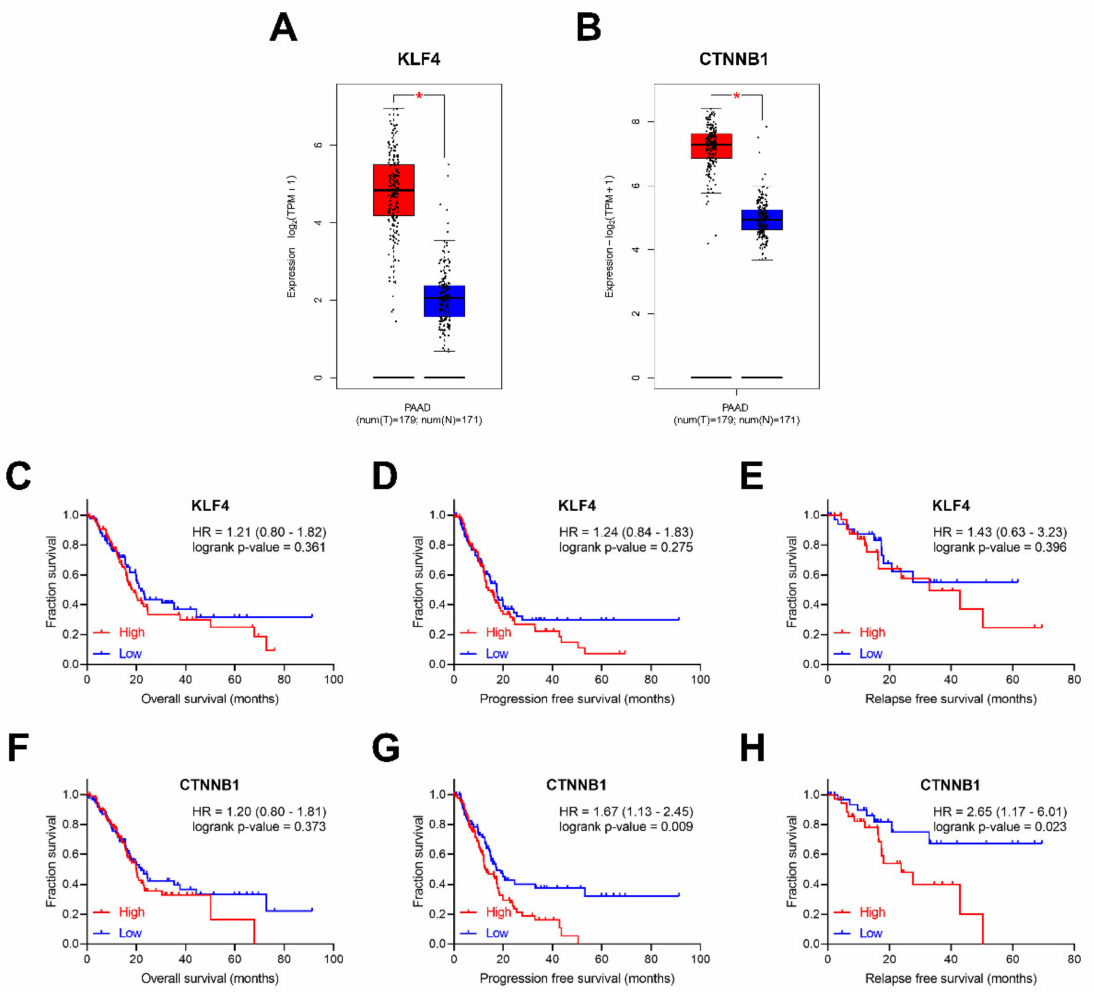
Figure 7. The clinical value of KLF4 and CTNNB1 . The box-plots with data overlaid dot plots for KLF4 ( A ) and CTNNB1 ( B ), showing expression in TCGA PAAD tumors with correspondent match PAAD normal tissue and GTEx pancreatic tissue. * p -value < 0.001. Clinical prognostic value of KLF4 , overall survival (OS) ( C ), progression-free survival (PFS) ( D ), and relapse-free survival (RFS) ( E ). Clinical prognostic value of CTNNB1 , OS ( F ), PFS ( G ) and RFS ( H ). Box plots were generated using GEPIA2 (available online: http: // gepia2.cancer-pku.cn / #index, accessed on 7 March